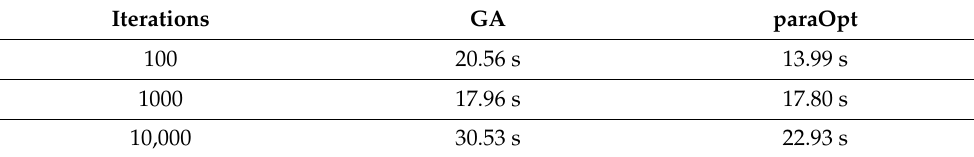
Table 7. CPU time for Face Contour Approximation Model